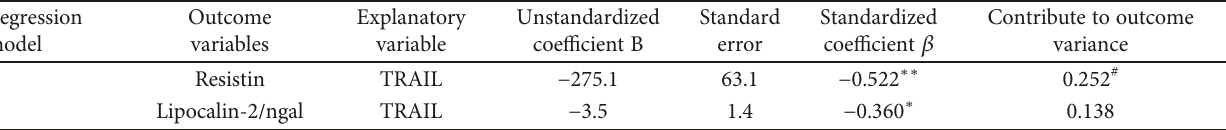
Both multiple regression models include age, hypertension, and waist circumference. B= unstandardized regression coe ffi cient; β =standardized regression coe ffi cient. # The squared semipartial correlation coe ffi cient accounts for the proportion of variance in the dependent variable that is explained by the covariate. ∗ p < 0 01 ; ∗∗ p < 0 001